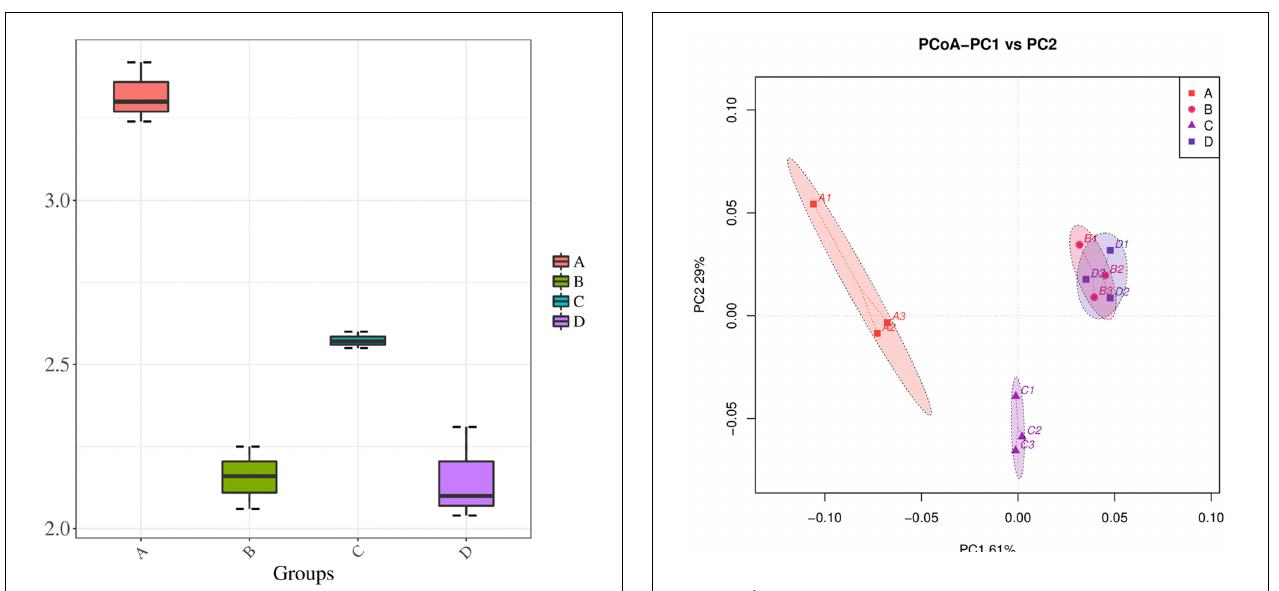
FIGURE 4 | Principal coordinate analysis (PCoA) profile of pairwise community dissimilarity (Bray-Curtis) indices for 16S V4 sequencing data for the B. napus L. phyllosphere obtained by four different treatments (A, B, C, and D). Ellipses represent the 95% confidence